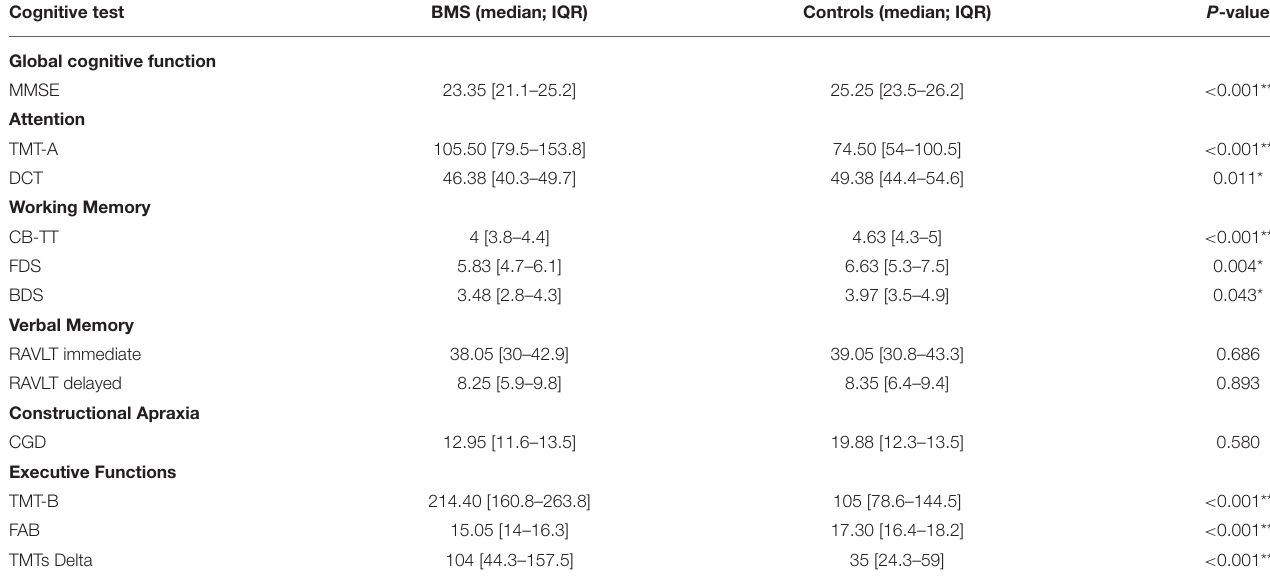
TABLE 7 | The analysis of cognitive tests of patients with BMS and control subjects. Cognitive